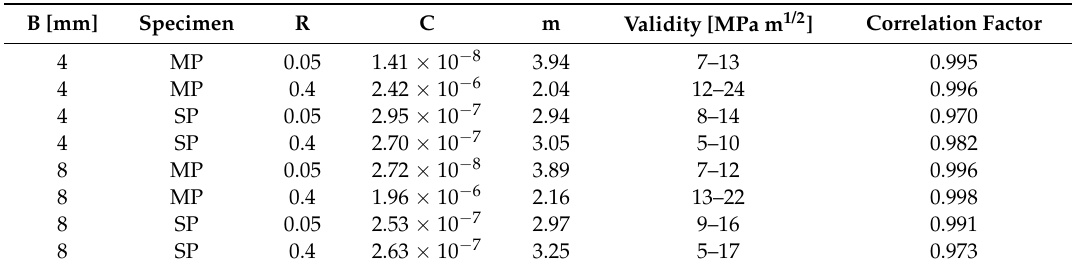
Table 3. Paris law parameters, C and m determined from da/dN vs. ∆ K curves (mm/cycle; MPa m 1/2 ). B